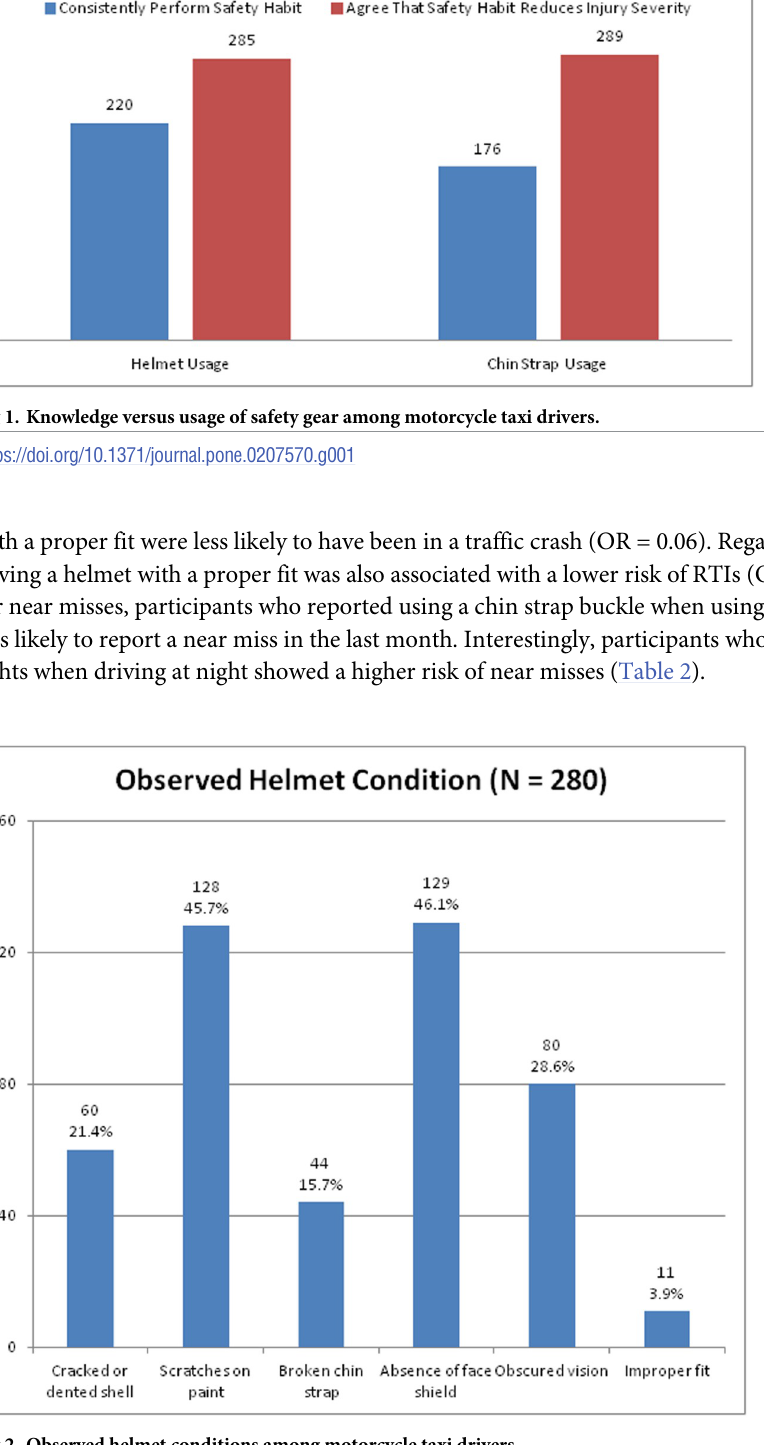
Fig 2. Observed helmet conditions among motorcycle taxi